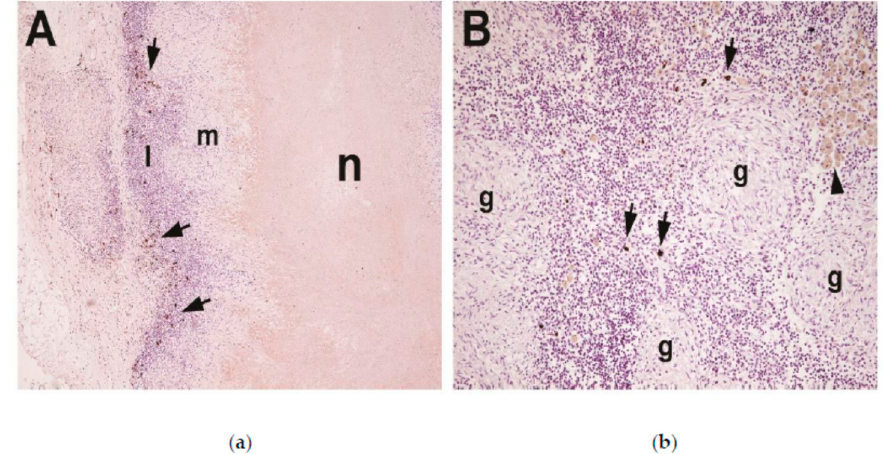
Figure 5. Immunohistochemical detection of IgA in TB-infected badger lymph node tissue. Tissue sections were prepared from badgers [20]. ( a ) Unvaccinated control animal (C037) with typical, large necrotic granuloma. IgA-positive cells (arrows) are observed within the outer layers of the granuloma surrounding the necrotic (n) core and the macrophage (m) layer. The majority of IgA positive cells are observed within the rim of lymphocytes (l), at 100 × magnification. ( b ) Animal vaccinated with BCG (C067) with small, solid, non-necrotic granuloma. Few IgA positive cells (arrows) are observed outside small, solid, non-necrotic granulomas (g). Silica-laden macrophages (arrowhead) are also observed, at 200 × magnification.